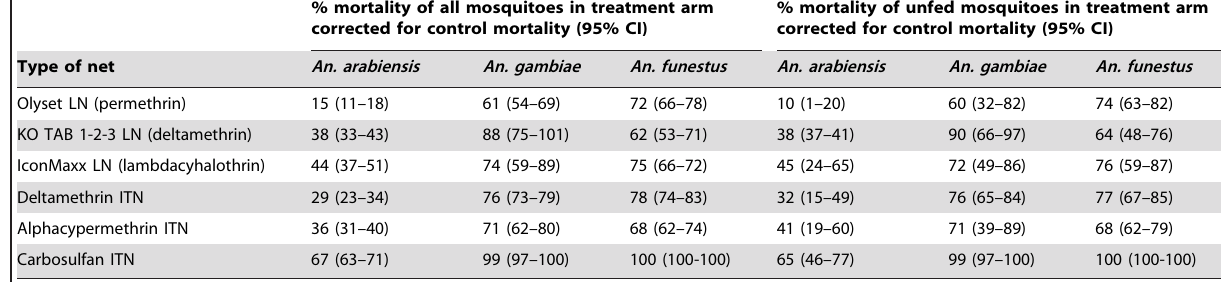
% mortality of all mosquitoes in treatment arm corrected for control mortality (95% CI)